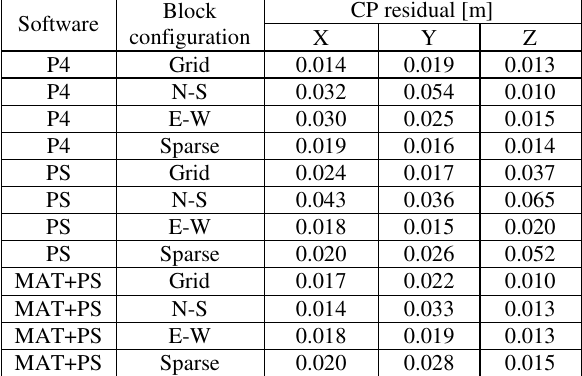
Table 2. CPs residuals after bundle block